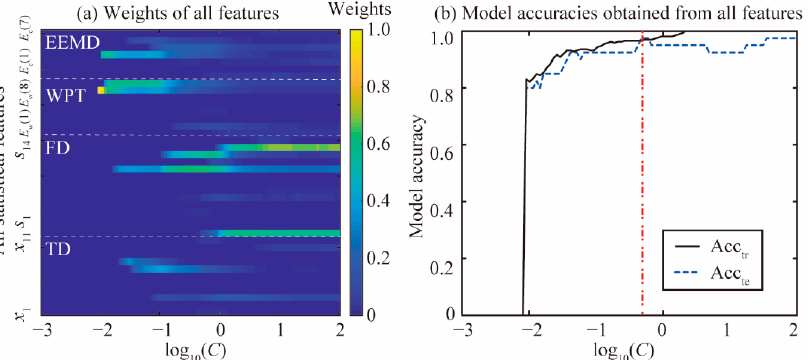
Figure 12. Weight variations and model accuracy for all features. ( a ) Weight variations of all features; ( b ) model accuracy obtained from all features.